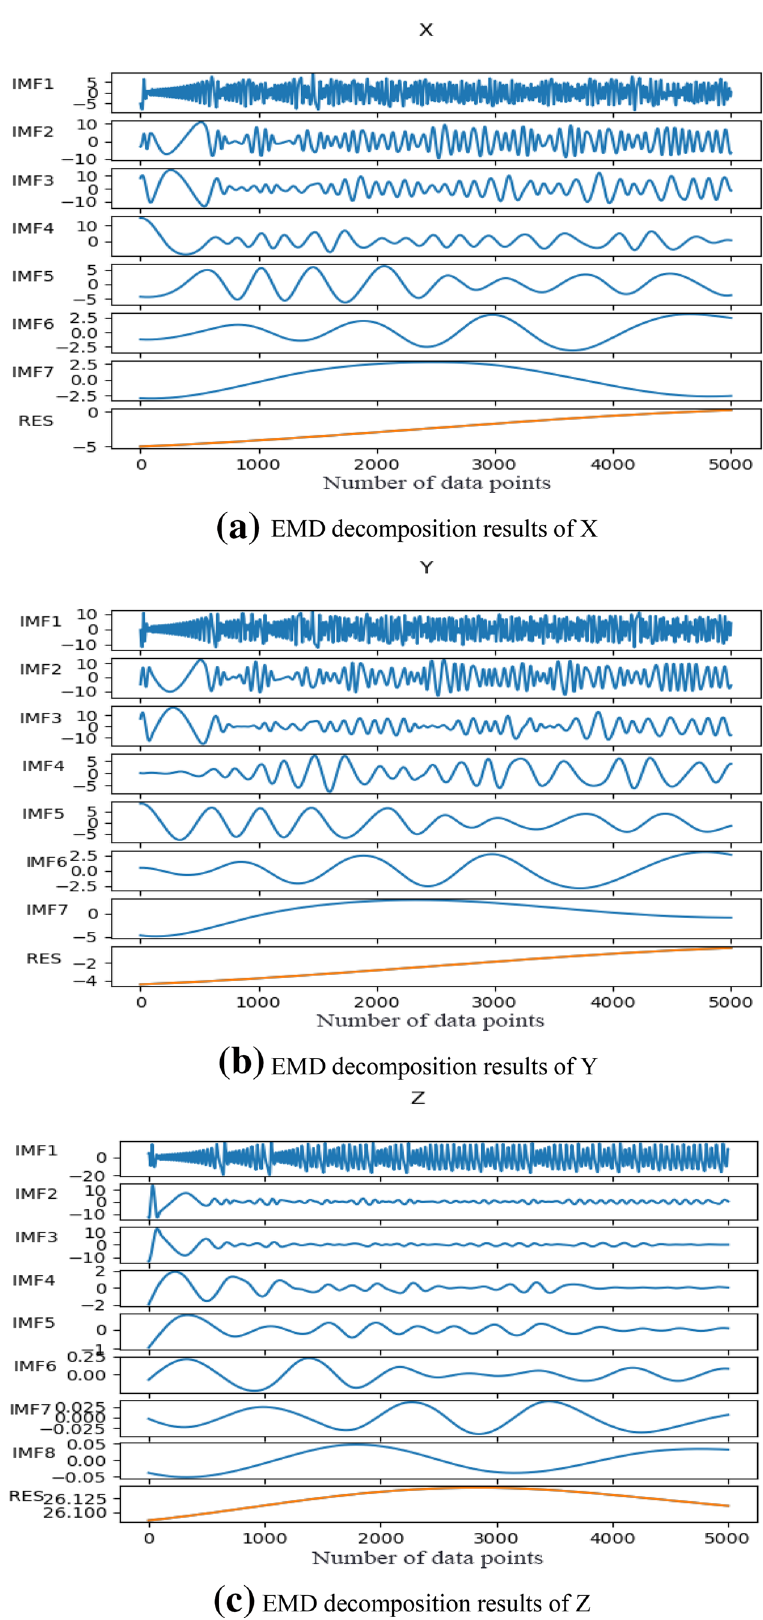
Fig. 1 EMD results of the Lorenz